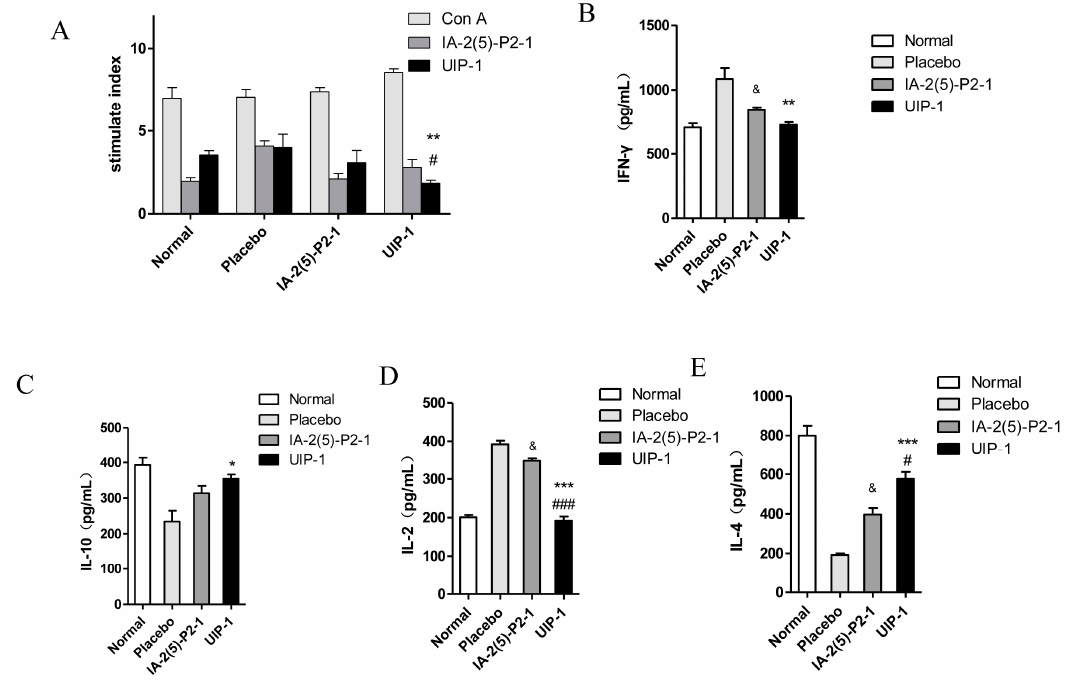
Figure 6. The effects of UIP-1 on immune responses in C57BL/6J mice. UIP-1 administration inhibited determinant spreading of T cell autoimmunity. At week 12 of the experiment, splenic T cells from the UIP-1 group, IA-2(5)-P2-1 group, and placebo were tested for proliferative responses to UIP-1, IA-2(5)-P2-1, and Concanavalin A (Con A). Data are expressed as the mean ± SEM stimulation index (SI) of triplicate samples ( n = 3/9). ( A ) The T cell proliferation in every group. The level of IFN- γ ( B ), IL-10 ( C ), IL-2 ( D ), IL-4 ( E ) after stimulated as above. * p < 0.05, ** p < 0.01, *** p < 0.001; UIP-1 versus placebo group. # p < 0.05, ## p < 0.01, ### p < 0.001, UIP-1 versus IA-2(5)-P2-1 group, & p < 0.05; IA-2(5)-P2-1 versus placebo group, one-way ANOVA.